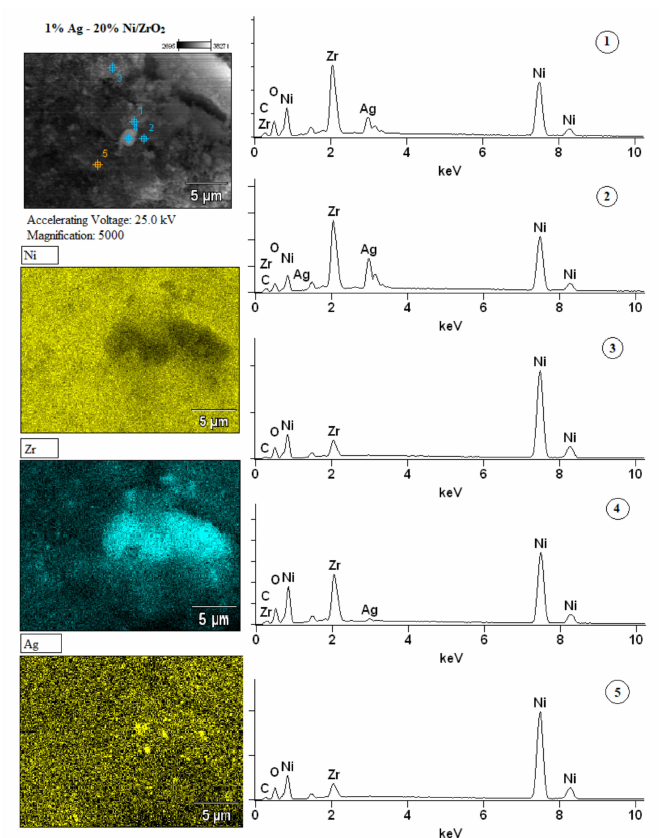
Figure 12. SEM images, EDS spectra collected from the marked points for bimetallic 1% Ag-20% Ni / ZrO 2